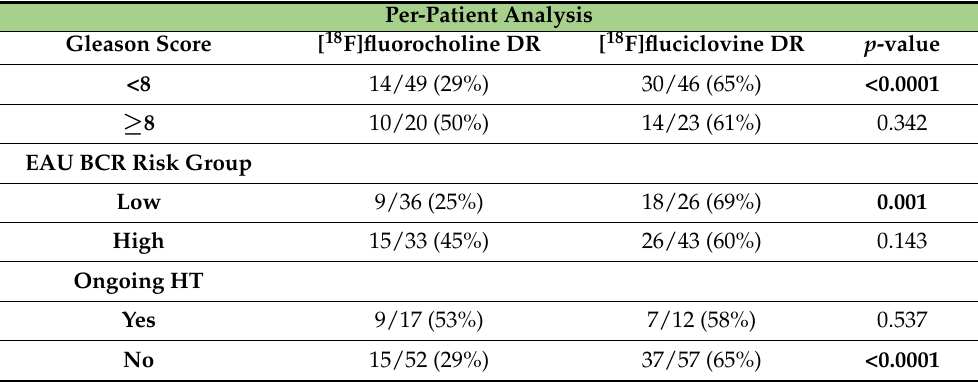
Table 4. Per-patient detection rate (DR) analysis comparing the [ 18 F]fluorocholine and [ 18 F]fluciclovine groups stratified according to Gleason Score, European Association of Urology (EAU) biochemical recurrence (BCR) risk group, and ongoing hormonal therapy (HT). Per-Patient Analysis